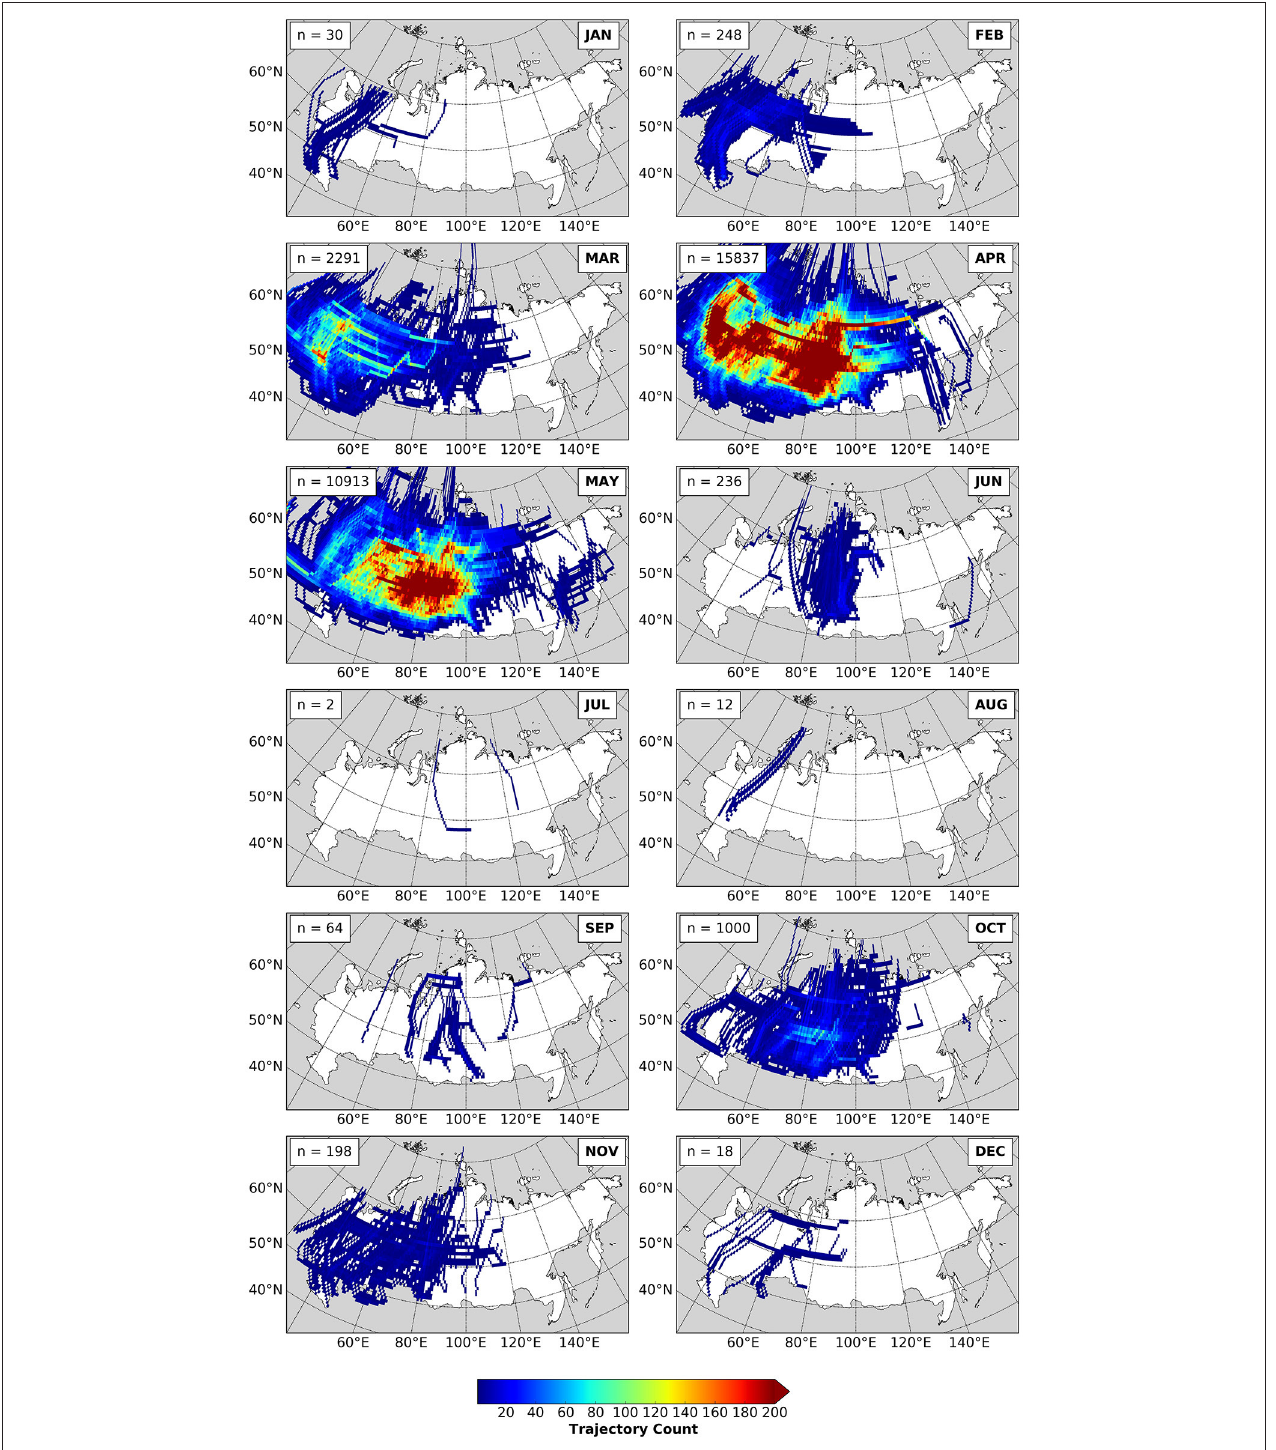
FIGURE 4 | The cumulative number of successful trajectories between 2003 and 2015 monthly at 925mb. See Figures S2–S5 for accompanying maps for cumulative trajectories at other injection heights examined within this study.